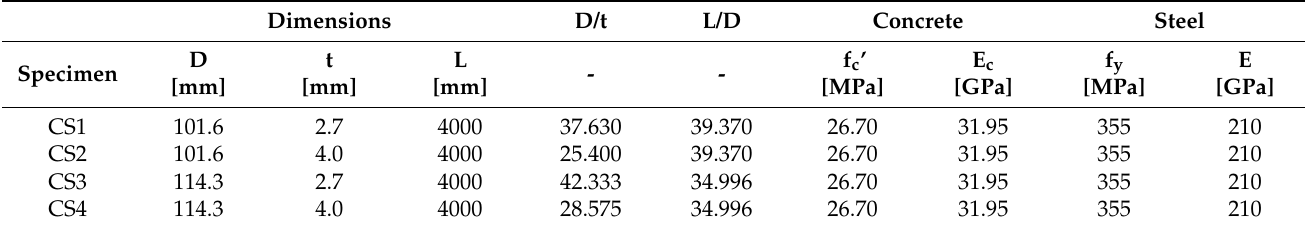
Table 1. Specimen dimensions and material